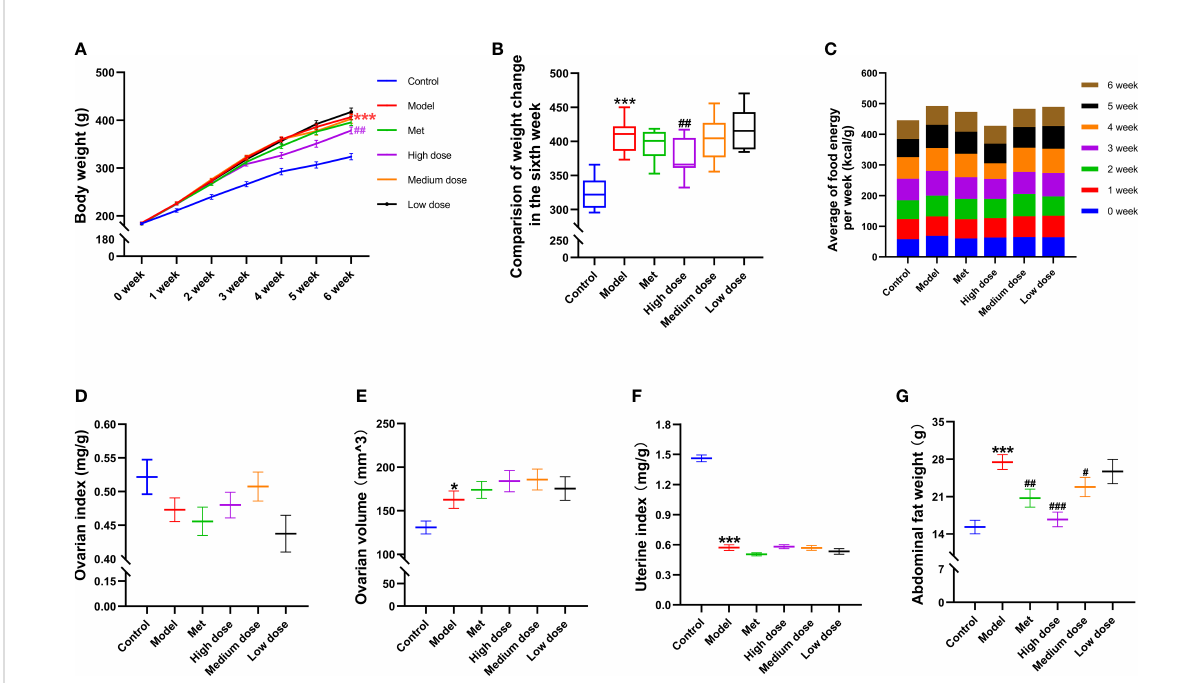
FIGURE 2 Effects of MCDD on body weight and organ index of rats. (A) The body weight change curve of the rats in each group for six consecutive weeks. (B) The body weight difference diagram of the rats in the six groups on the sixth week. (C) The average free food intake energy of the six groups of rats was counted every day. After sacri fi ce, the weight of ovary, uterus, and abdominal fat were weighed, and the ratio to body weight was (D) ovarian index. (E) ovarian volume (mm 3 ) = ( p /6) × long diameter (mm) × short diameter 2 (mm 2 ). (F) uterine index. (G) abdominal fat index of rats. The above results are expressed as mean ± SEM, n = 8~12. *** P < 0.001, * P < 0.05, vs. control group, ### P < 0.001, ## P < 0.01, # P < 0.05, vs. model